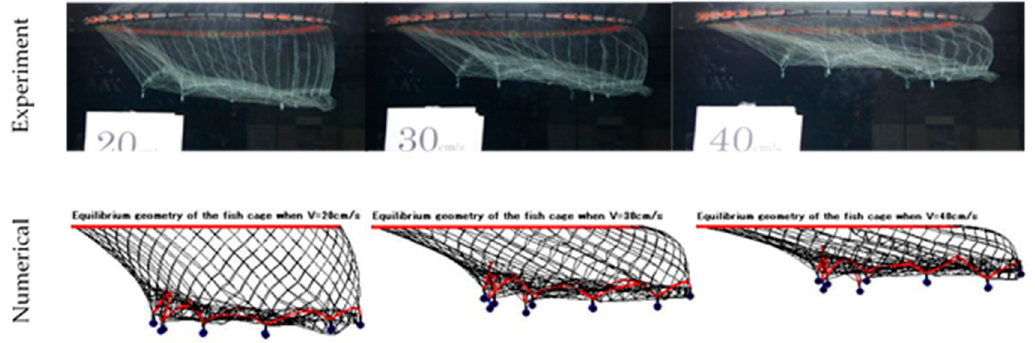
Figure 15. Snapshots from experimental and numerical simulations.